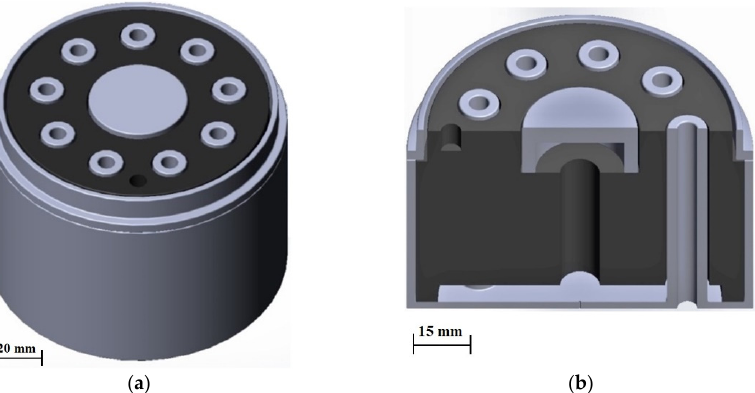
Figure 2. Three-dimensional model of the modernized equipment: ( a ) “new” tooling and sketch of the assembled block and ( b ) section of the 3D model.